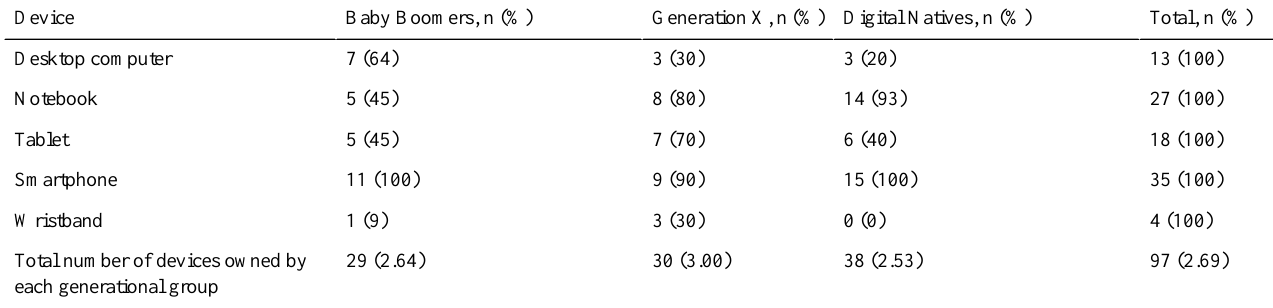
Table 2. Participant ownership of internet-capable devices